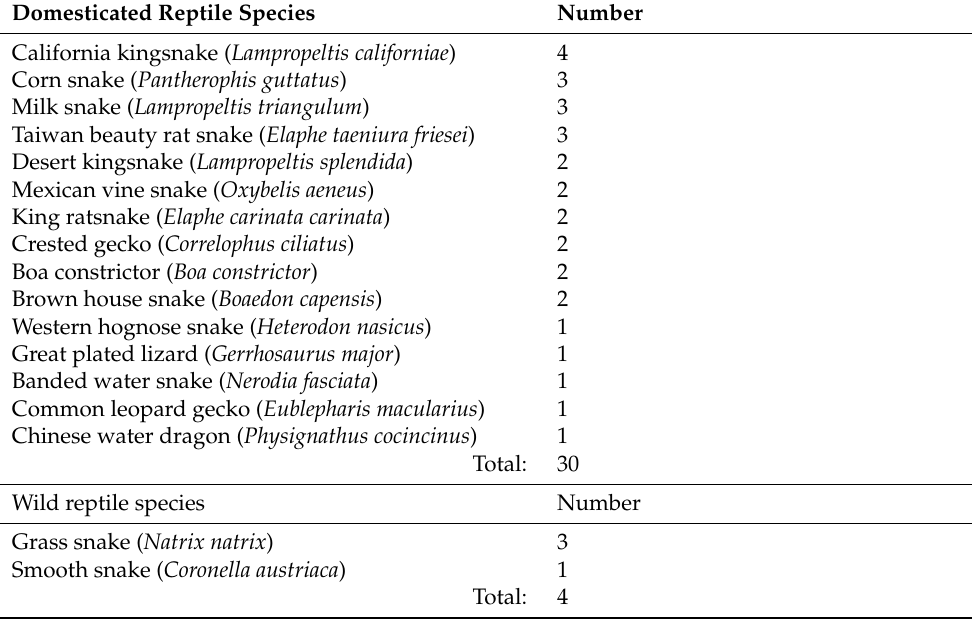
Table 6. Species of reptiles carrying antimicrobial resistant Salmonella